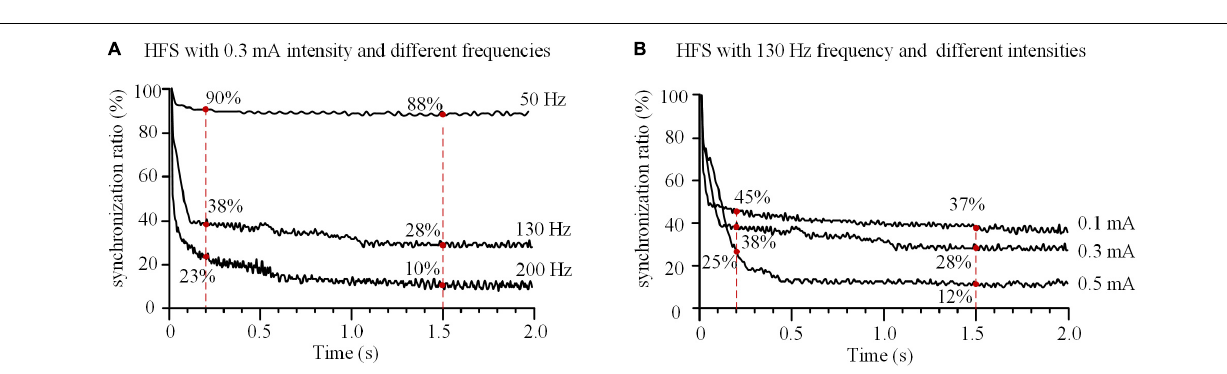
FIGURE 6 | Effects of frequency and intensity of high-frequency stimulation (HFS) on the synchronization of action potential firing of an axonal bundle. (A) Changes of the synchronization ratios during HFS with different frequencies at a fixed intensity (0.3 mA). (B) Changes of the synchronization ratios during HFS with different intensities at a fixed frequency (130